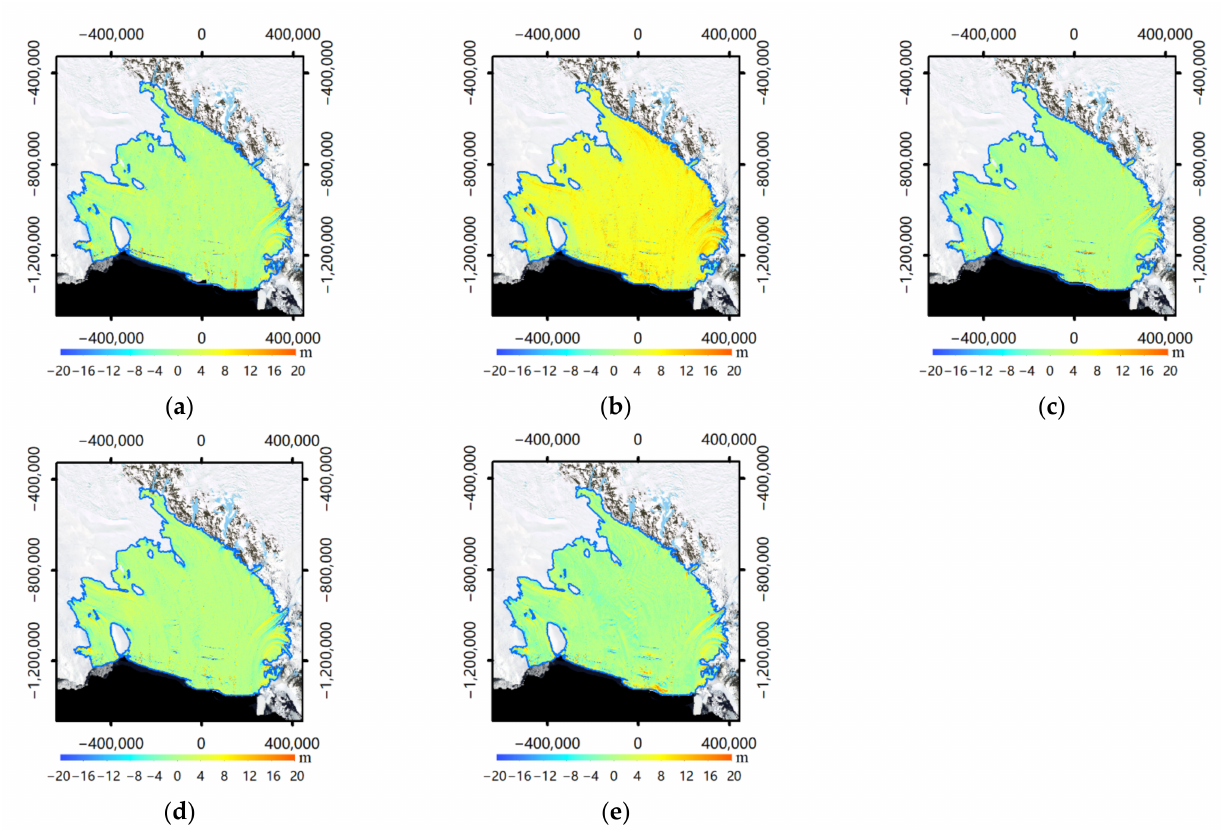
Figure 6. Distribution of elevation differences between the ICESat-2 RIS DEM and five previously published Antarctic DEMs, i.e., Reference Elevation Model of Antarctica (REMA) ( a ), TanDEM PolarDEM ( b ), Slater CryoSat-2 DEM ( c ), Helm CryoSat-2 DEM ( d ), Bamber DEM ( e ). Maps are in the polar stereographic projection in